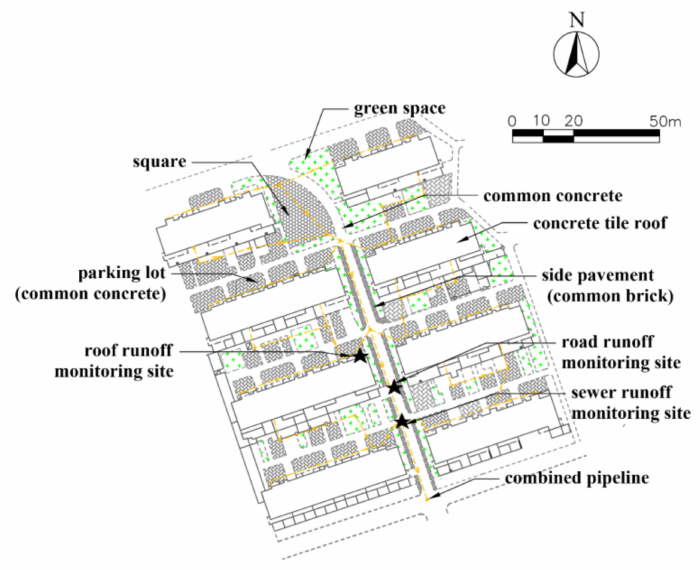
Figure 1. Conventional drainage unit (1.19 ha; roof and road runoff systems were collected by a combined pipeline and eventually fed into the sewer